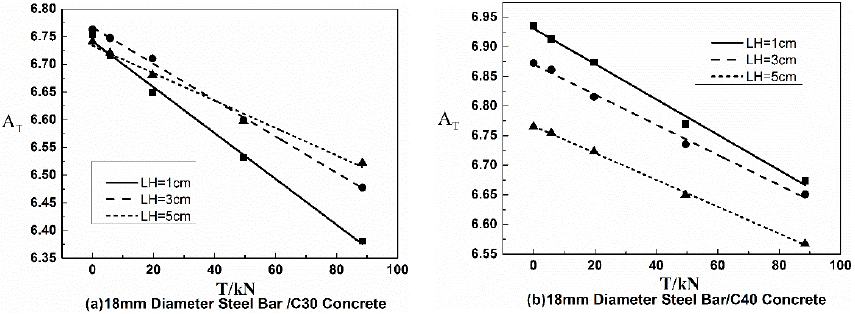
Figure 9. Linear portions of A T – T diagrams with different strengths of outer concrete and different steel bar diameter specimens, at different LHs.